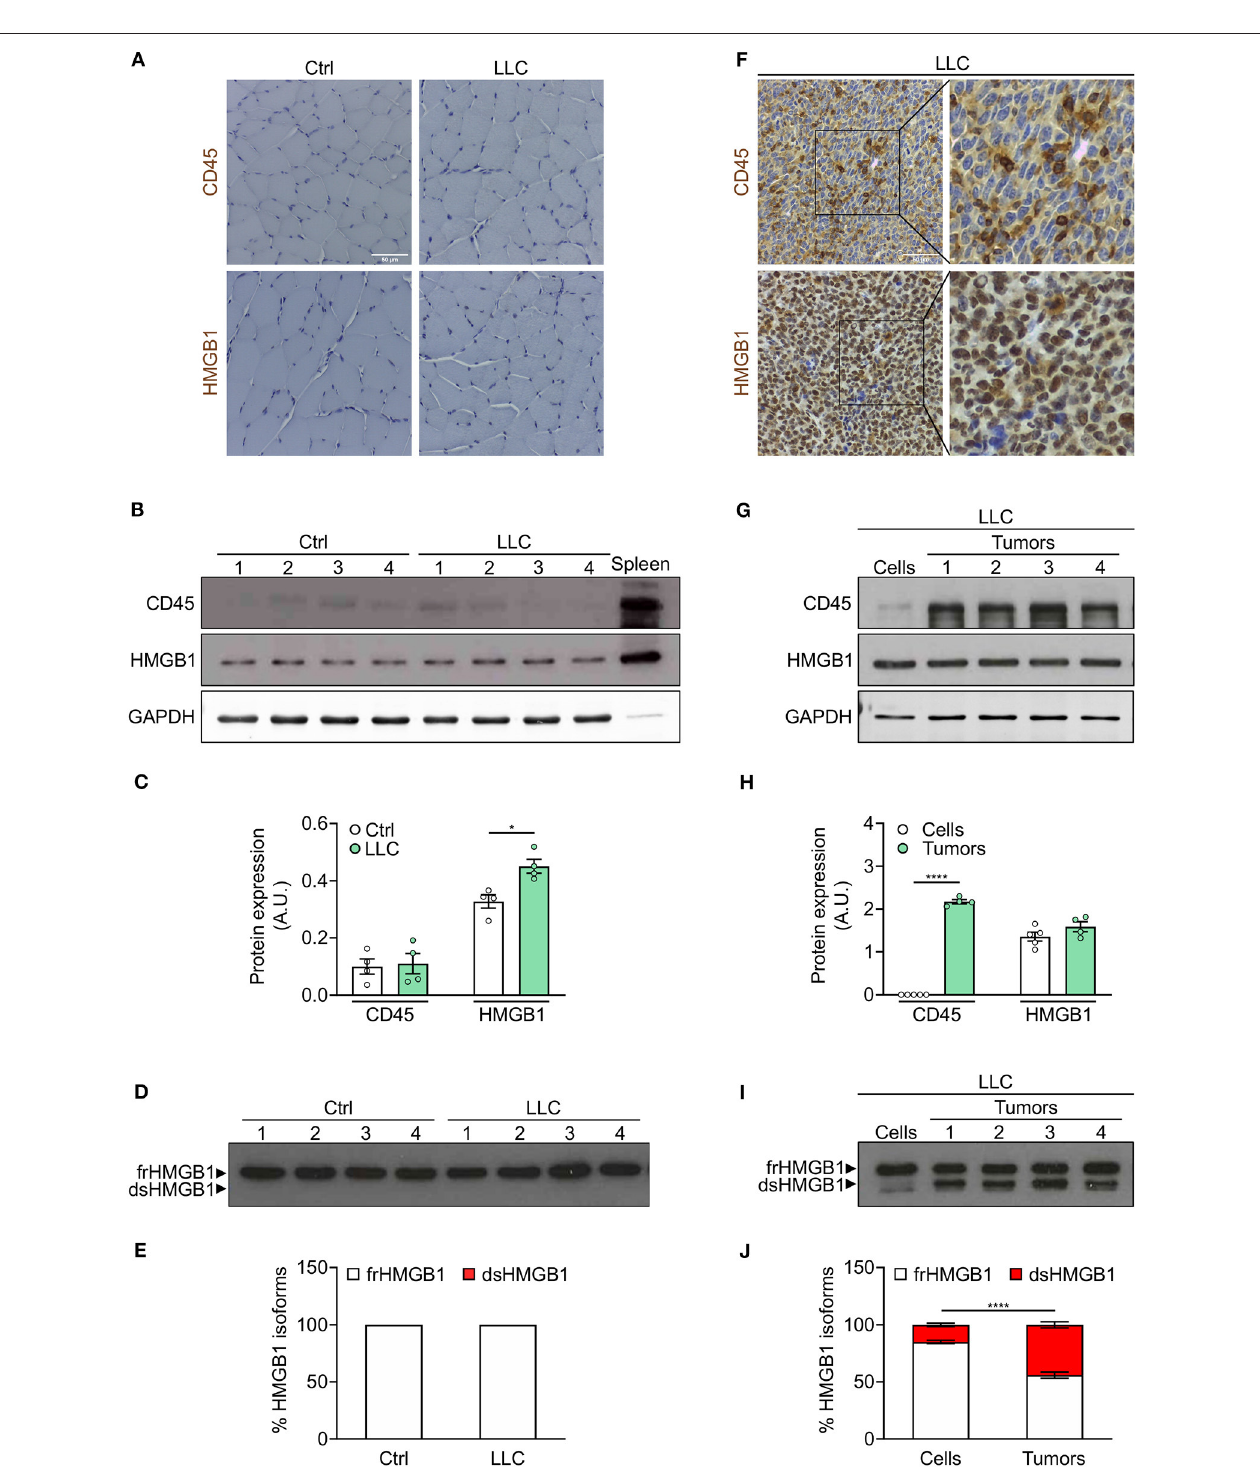
FIGURE 4 | Leukocytes operate as transporter of dsHMGB1 in tumor microenvironment. (A) Representative images of immunohistochemical staining for CD45 (upper panel) and HMGB1 (lower panel) on tibialis anterior (TA) muscle sections from control (Ctrl) vs. Lewis lung carcinoma (LLC)-bearing mice. Scale bars, 50 µ m. (B,C) Western blot probed with anti-CD45, anti-HMGB1, and anti-GAPDH antibodies in reducing conditions (B) , and quantification of total CD45 and HMGB1 protein levels normalized on GAPDH (C) ( n = 4 mice). In (B) , spleen lysate (5 µ g) was added as positive control for CD45 expression. (D) Western blot probed with anti-HMGB1 antibody in non-reducing conditions on tibialis anterior (TA) lysates from control or LLC-bearing mice. The upper and lower bands in non-reducing conditions